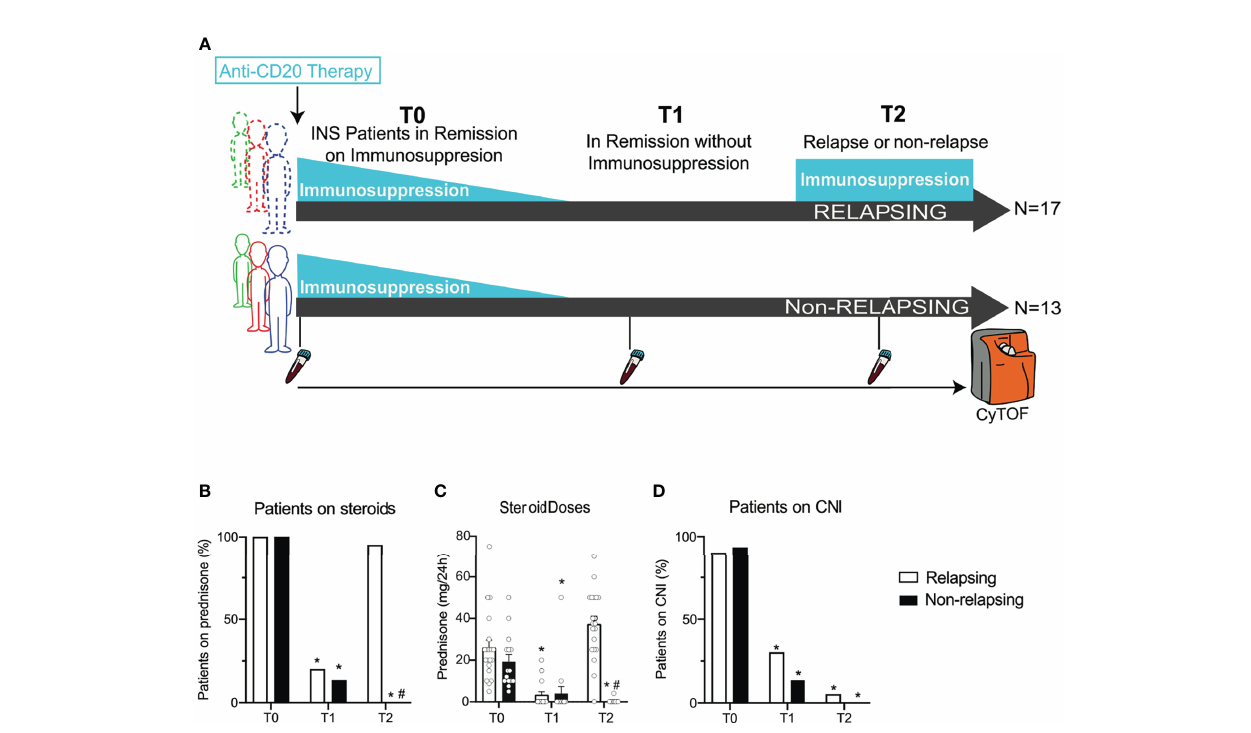
FIGURE 1 | Serial high-dimensional pro fi ling of INS patients and concomitant immunosuppressive treatments. (A) Study design of thirty children with steroid- dependent nephrotic syndrome in remission with steroids ± calcineurin inhibitors who received either rituximab (RTX) or ofatumumab (OFA) and then underwent withdrawal of immunosuppression in 3 months. After withdrawal, 17 patients developed a relapse, while 13 stayed in remission. Blood was collected before RTX or OFA therapy (T0), after immunosuppressive withdrawal (while still in remission; T1), and at the time of relapse (or at the same time after B cell depleting therapy in patients in remission; T2). Cells were barcoded for patient and time, pooled, and stained with 38 antibodies conjugated to unique metal isotopes. Single-cell data acquired from time-of- fl ight mass cytometry (CyTOF) was clustered using Phenograph to identify cell clusters and how they evolved over time in each patient (see Methods). (B) Percentage of patients treated with prednisone and (C) average daily prednisone doses in relapsing and non-relapsing patients before anti-CD20 therapy (T0), in remission after immunosuppression withdrawal (T1), and at relapse (or at the same time point after anti-CD-20 therapy in non-relapsing patients; T2). (D) Percentage of patients treated with calcineurin inhibitors (CNI) at the same visits. n=30. *p < 0.05 vs . T0. # p < 0.05 vs . relapsing at the same visit. Bar plots depict mean ±